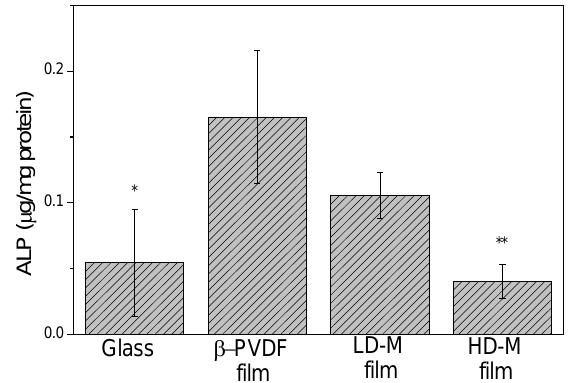
Figure 5. Alkaline phosphatase (ALP) activity in hMSCs cultured on different substrates for seven days. * The ALP activity of cells on β -PVDF film was significantly higher than that on high density (HD-M) film and glass ( p < 0.05). Data are expressed as the mean standard deviation with n = 3. * p ≤ 0.05 vs. β -PVDF film and ** p ≤ 0.01 vs. β -PVDF film.